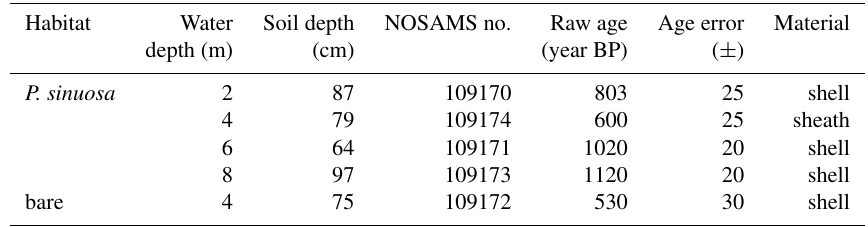
Table A1. Details of radiocarbon dating of the P. sinuosa sheaths and shells from the cores. The accession laboratory sample assigned by NOSAMS is